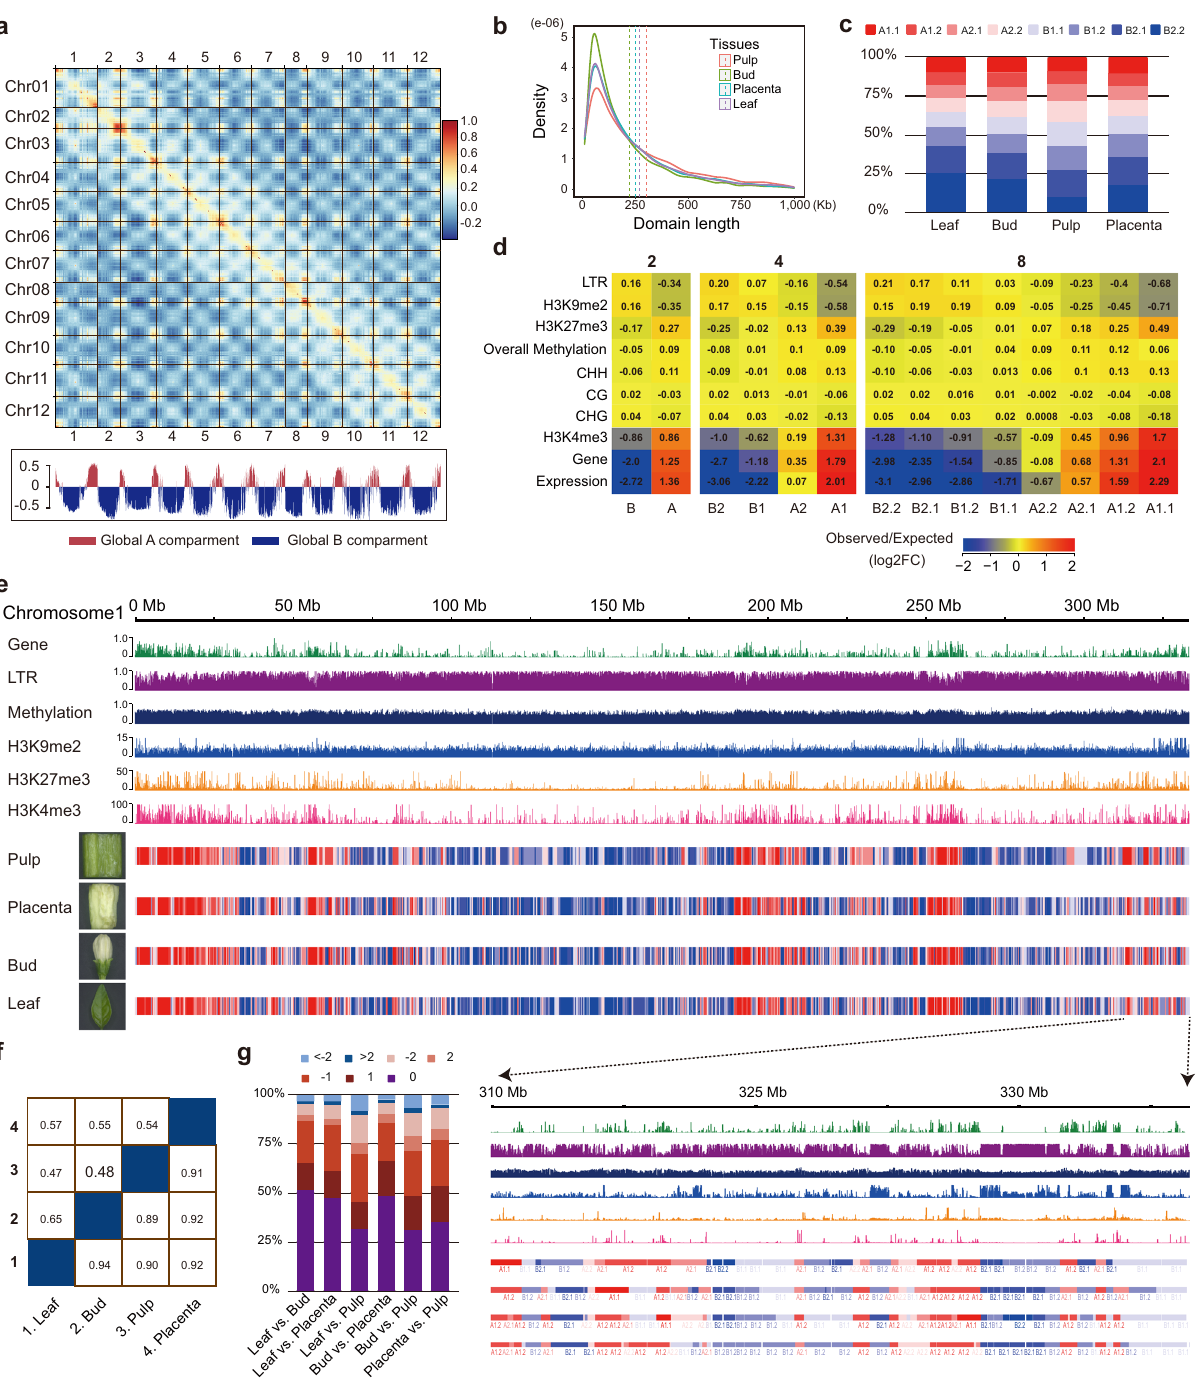
bin map of a leaf) based on a set of genomic (e.g., LTR and gene density) and epigenomic features (e.g., DNA methylation and histone modi fi cations such as H3K4me3, H3K9me2, and H3K27me3) within their bodies and recovered three major groups (Fig. 4a). We labeled domains in group 1 ( n = 315) as active because of their enrichment for genes and the active chromatin mark H3K4me3; domains in group 2 ( n = 1011) as inactive, because of their high levels of DNA methylation sum across CG, CHG, and CHH contexts; and domains in group 3 ( n = 1315) as HDF (heterochromatin-driven folding) because they are enriched for LTR retrotransposons and the hetero- chromatin mark H3K9me2 (Fig. 4b and Supplementary Fig. 13a). NATURE COMMUNICATIONS| (2022) 13:3479